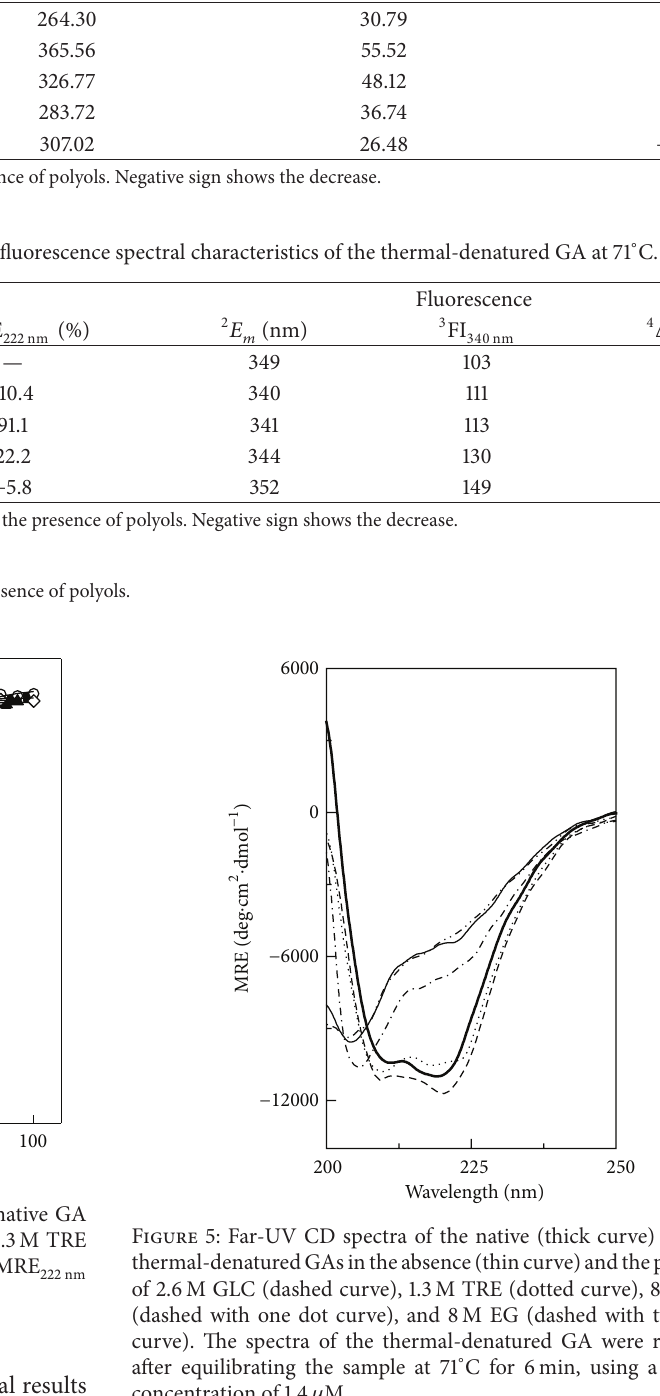
Table 3: Thermodynamic parameters for thermal denaturation of glucoamylase as monitored by CD spectroscopy. Glucoamylase